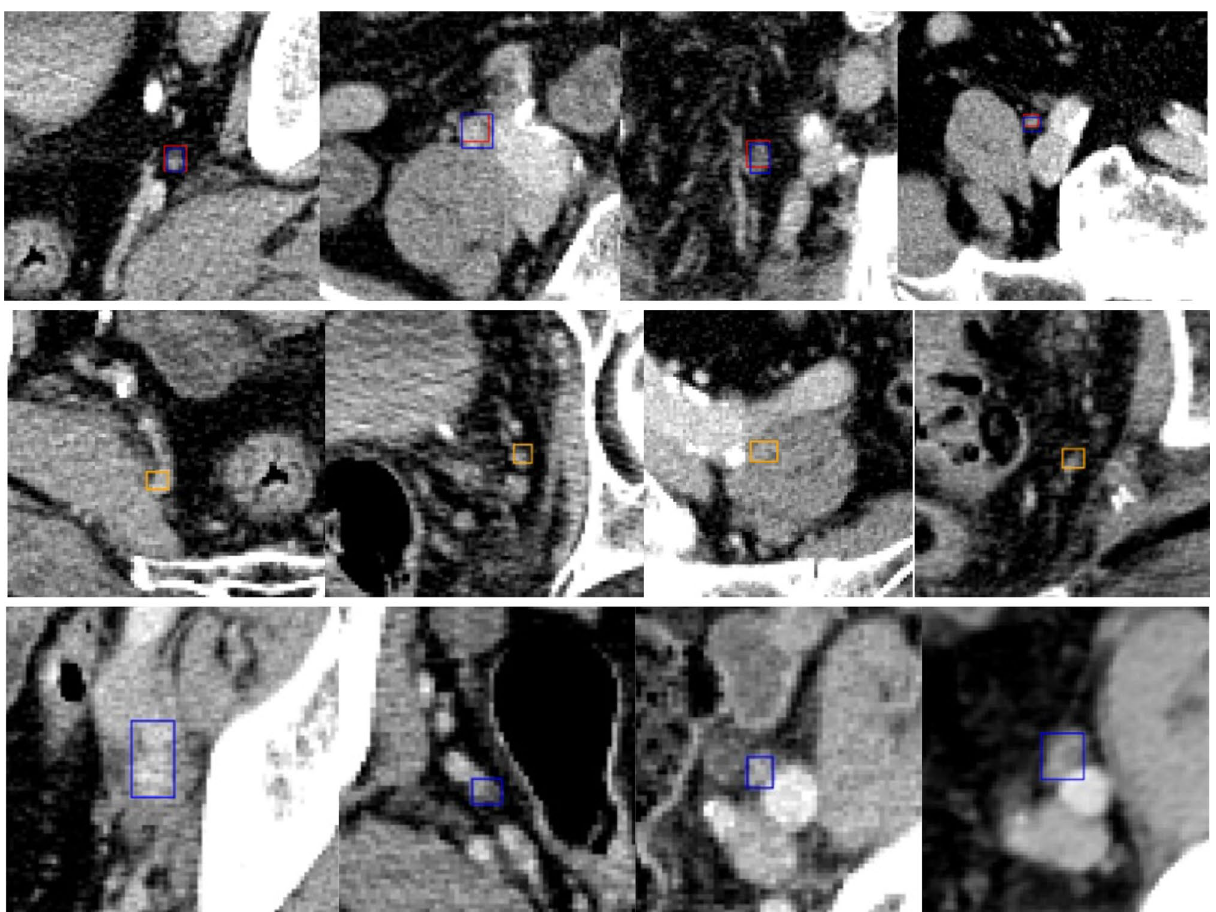
Figure 5. Examples of 2.5D Object Detection Pipeline Prediction on the test set. Images are zoomed in to better visualize the detection boxes. Boxes in red are TPs, in orange are FPs, in blue are GTs. The first row is the visualization of TPs, the second and last are for FPs and FNs,